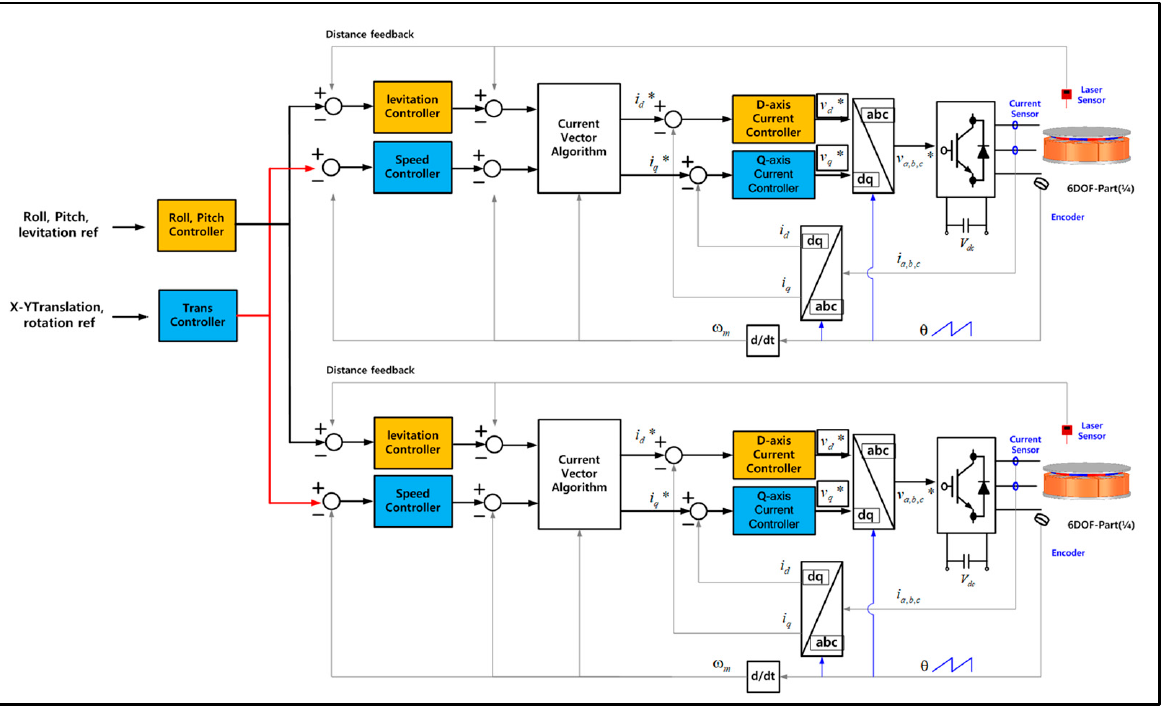
Figure 13. Control block diagram for the integrated driving control of the 6 − DOF magnetic levitation system (* is command value).